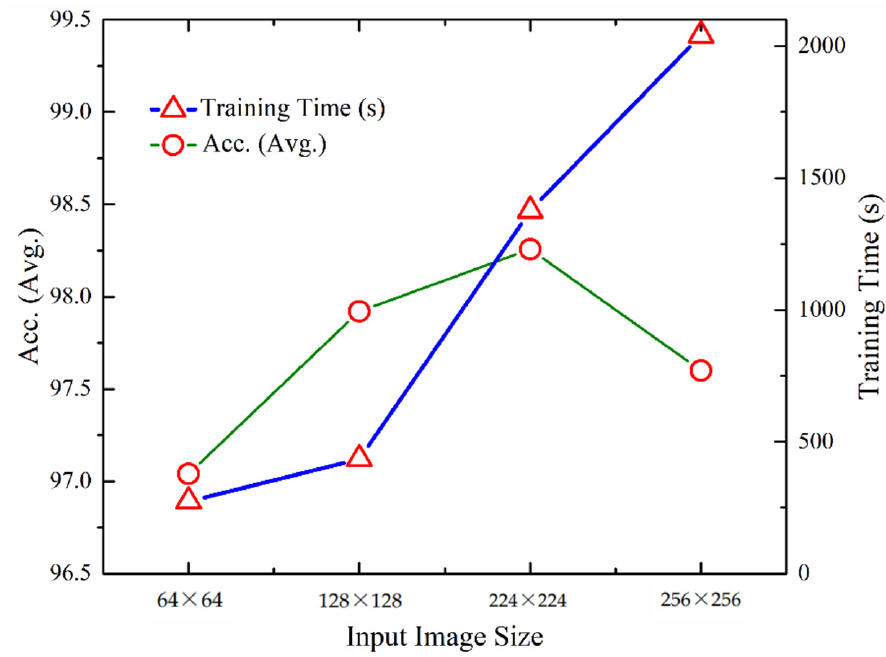
Figure 8. Comparison of performance and training times using different input layer sizes for UL-DLA (without